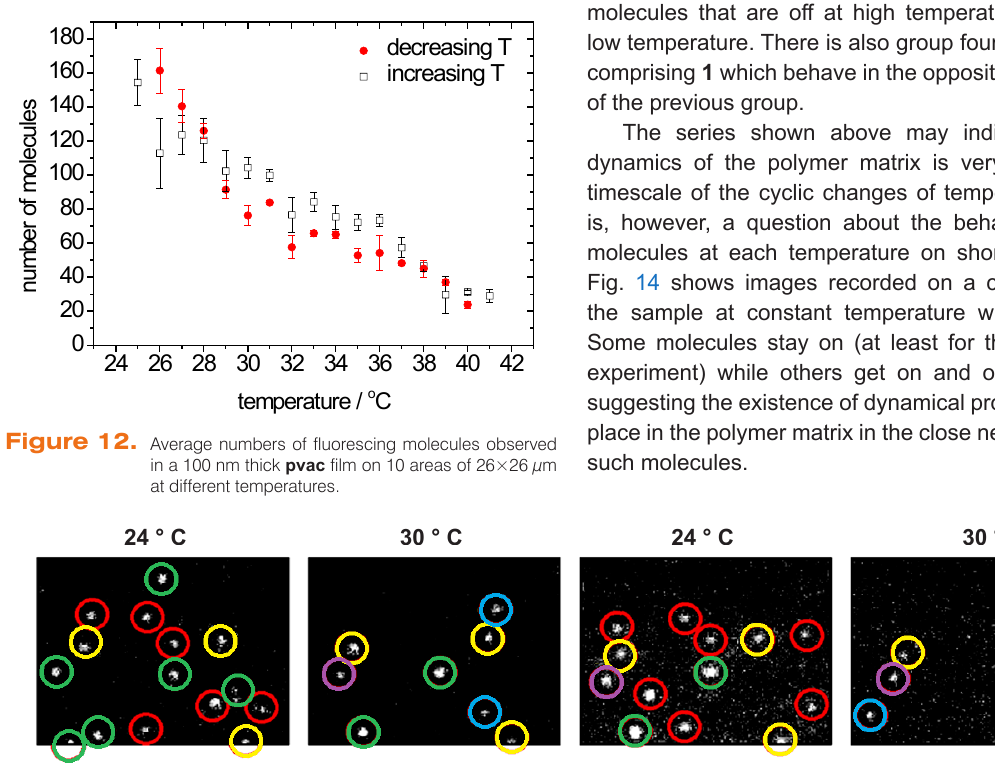
Figure 13. Sequence of wide-field images of one area of sample containing 1 embedded in a pvac film showing two cycles of changing temperature from 24°C and 30°C. Size of the images ca. 13×9 µm. Accumulation time: 1 s.